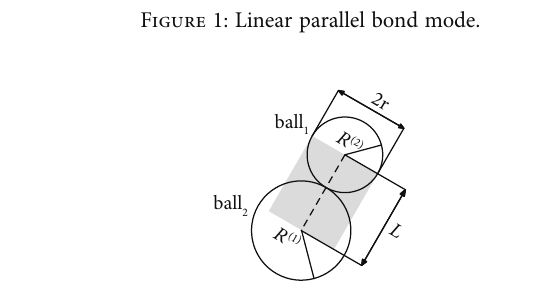
Figure 2: Linear parallel bond contact of